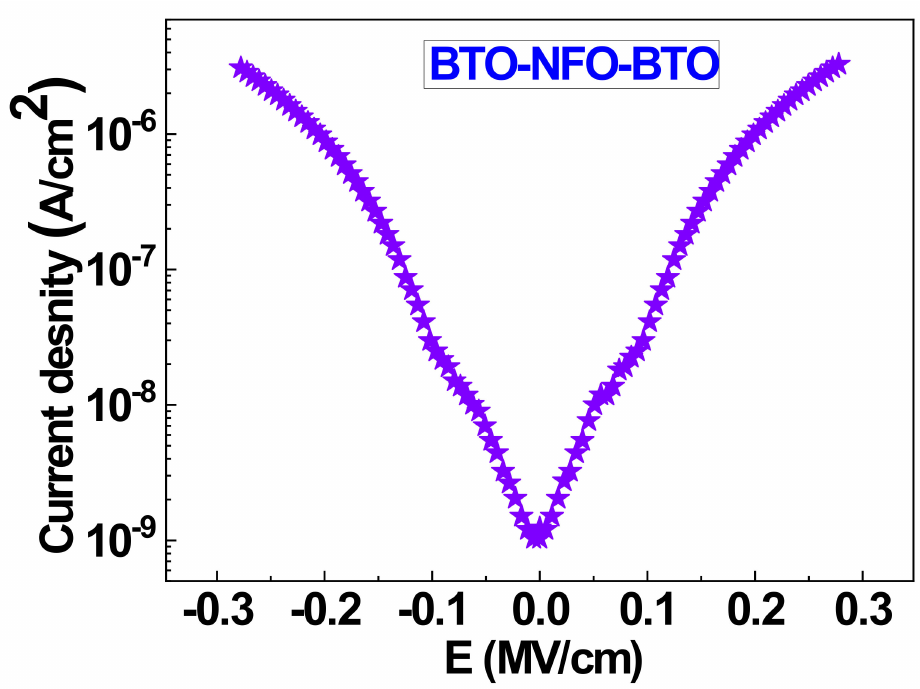
Figure 4. Leakage current behavior (current density versus voltage) of (BTO/NFO/BTO) tri-layered thin film on substrate Pt/Ti/SiO 2 /Si at room